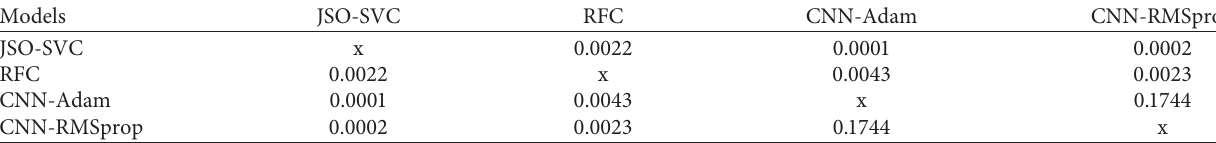
Figure 15: Boxplot of AUC values obtained from the employed machine learning models. Table 3: p values obtained from the Wilcoxon signed-rank test results with CAR index.